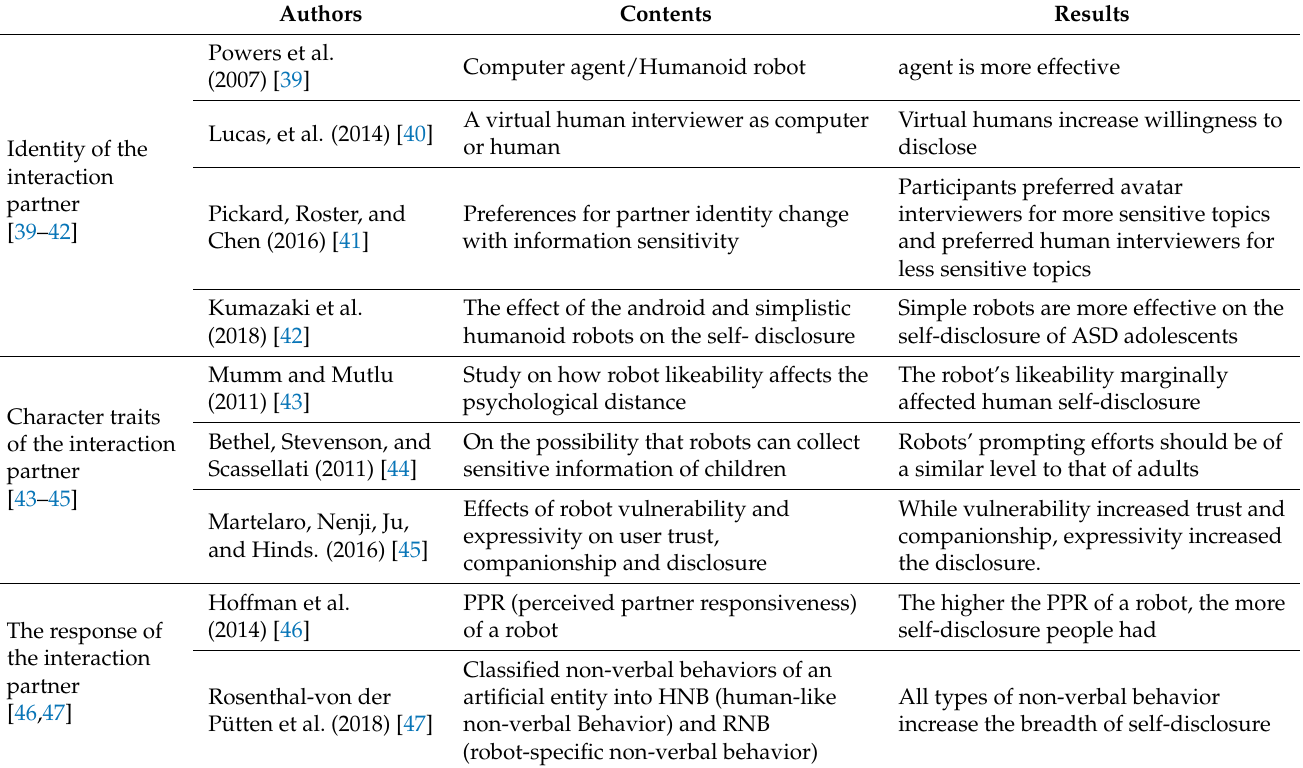
Table 1. Prior studies on eliciting